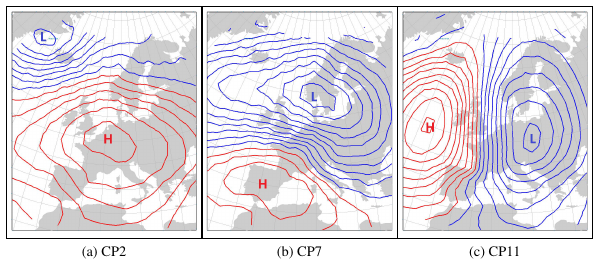
Fig. 10. 1hPa isobars of the mean sea level pressure anomalies of CPs related to high precipitation intensities according to the 20th- century run of ECHAM5.